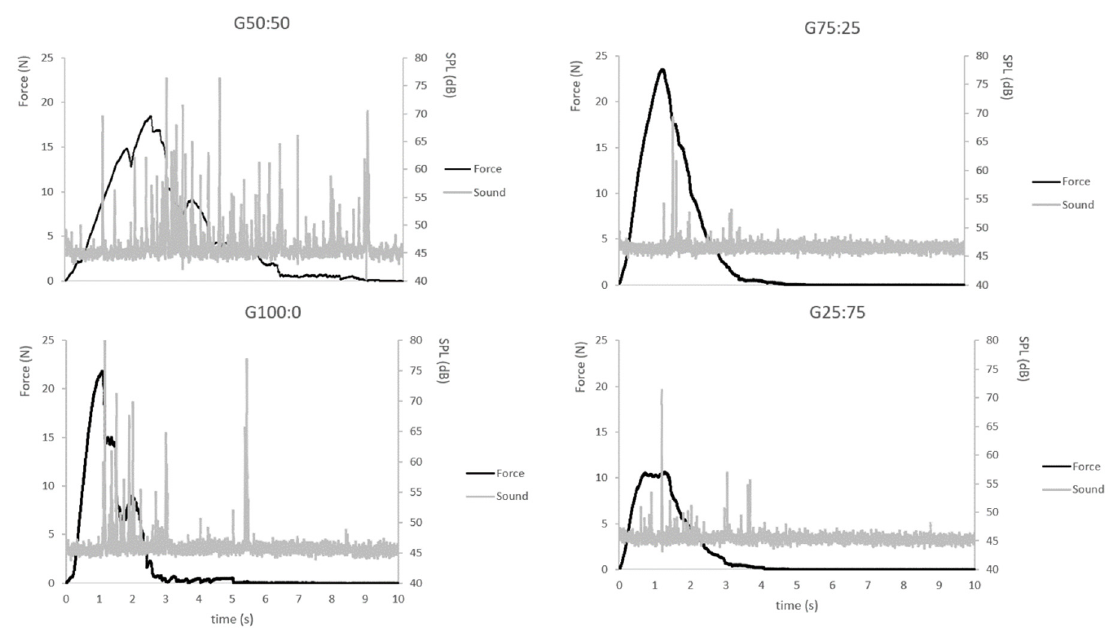
Figure 1. Force–time and sound–time curves for the four chickpea biscuit formulations. Each graph corresponds to a single texture analysis measurement performed for each biscuit. It shows the force and acoustic pressure level (SPL) during the breaking of the biscuit. G100:0 = 100% CF/0% RF; G75:25 = 75% CF/25% RF; G50:50 = 50% CF/50% RF; G25:75 = 25% CF/75% RF.